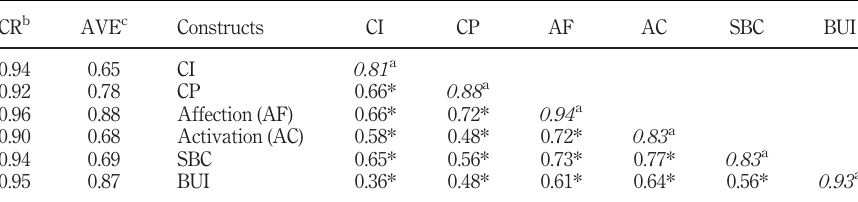
Table I. Constructs validity